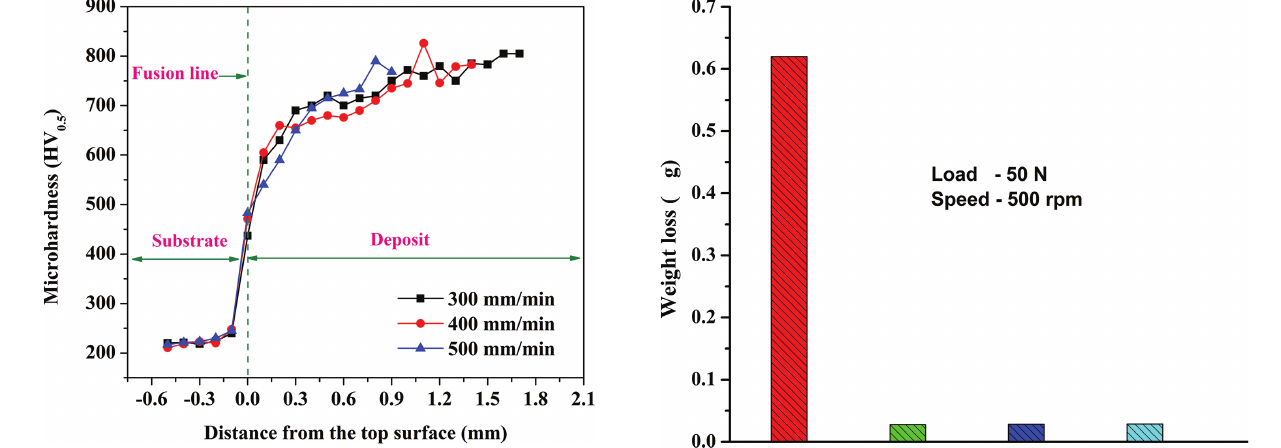
Figure 14: Effects of travel speed on microhardness. Table 6: Pin on disc wear test parameters.